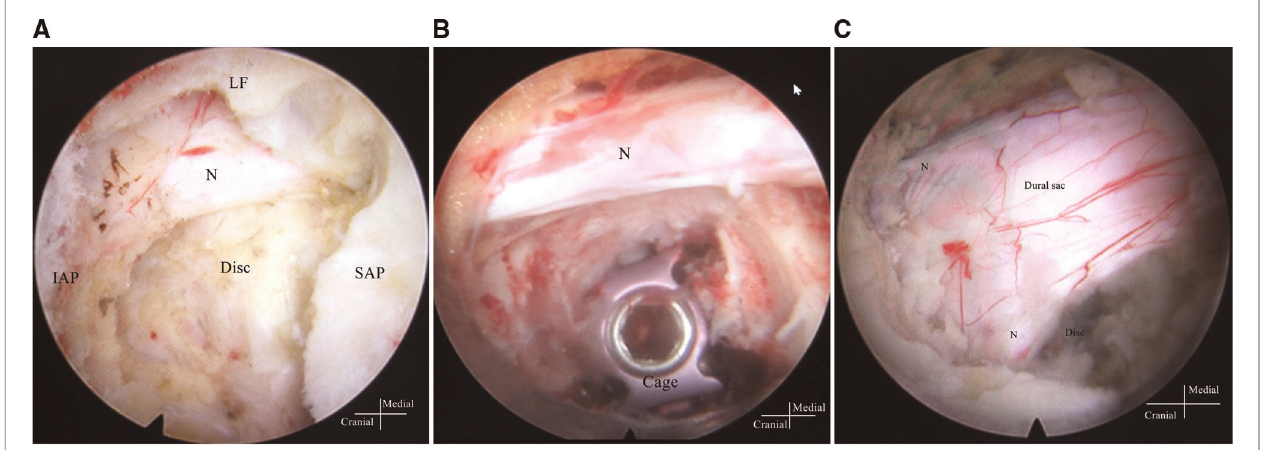
FIGURE 1 | Images under endoscopy. ( A ) The SAP is exposed after the IAP is excised, and the nerve root and disc are exposed after the SAP is excised. ( B ) The cage and the nerve root after inserting the cage. ( C ) The dural sac and the bilateral nerve root after unilateral laminotomy for bilateral decompression.